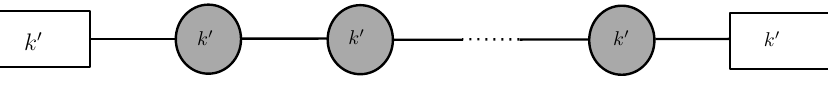
Table 4 . BPS/4 brane intersection underlying the massless AdS 7 / Z k solution to Type IIA. The 6d (1,0) dual CFT lives in the ( t, x 1 , x 2 , x 3 , x 4 , x 5 ) directions. x 5 is the Taub-NUT direction of the KK-monopoles. y is the field theory direction.